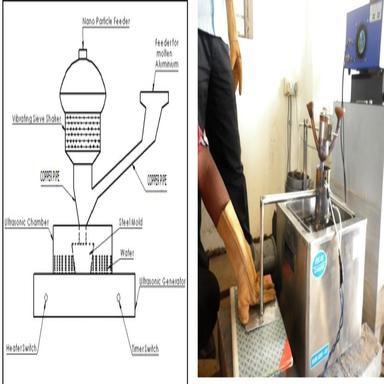
Schematic diagram of the experimental setup.